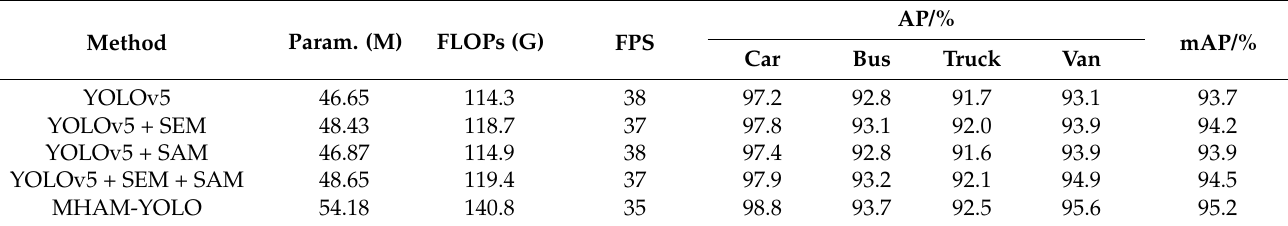
Table 2. Ablation study of ASPP and FPN